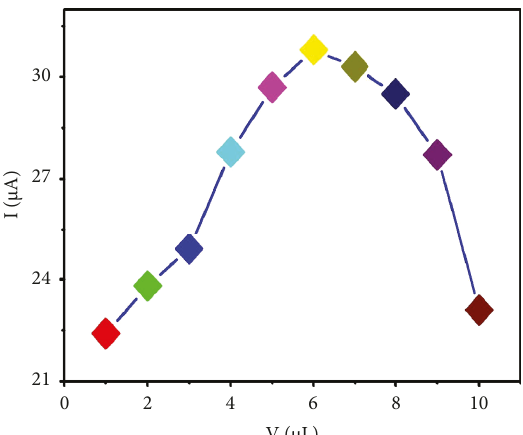
Figure 6: Effect of the amount of Cu/rGO suspension on the current of reduction peak (5.0 μ M HQ at 120mV · s − 1 scanning rate).